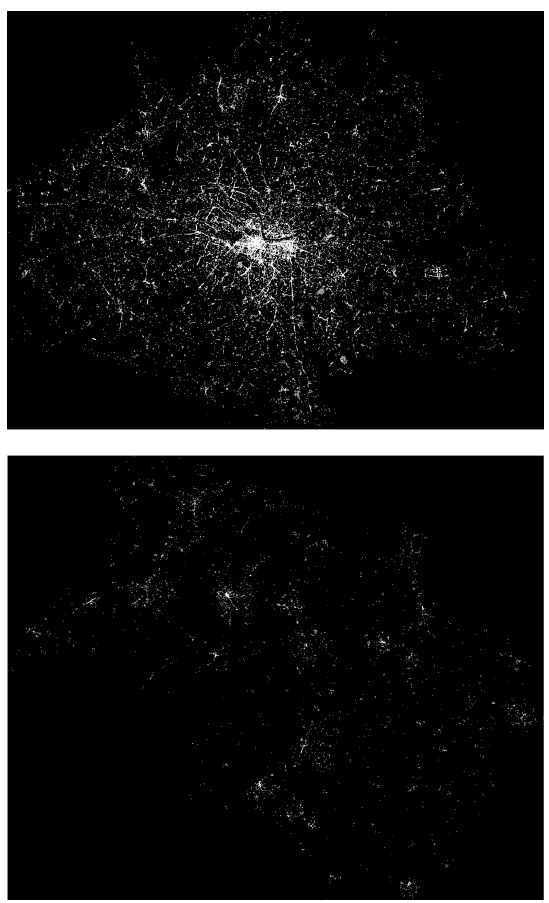
Figure 1. Distribution of landmark candidates in Greater London ( top ) and Hertfordshire ( bottom ).